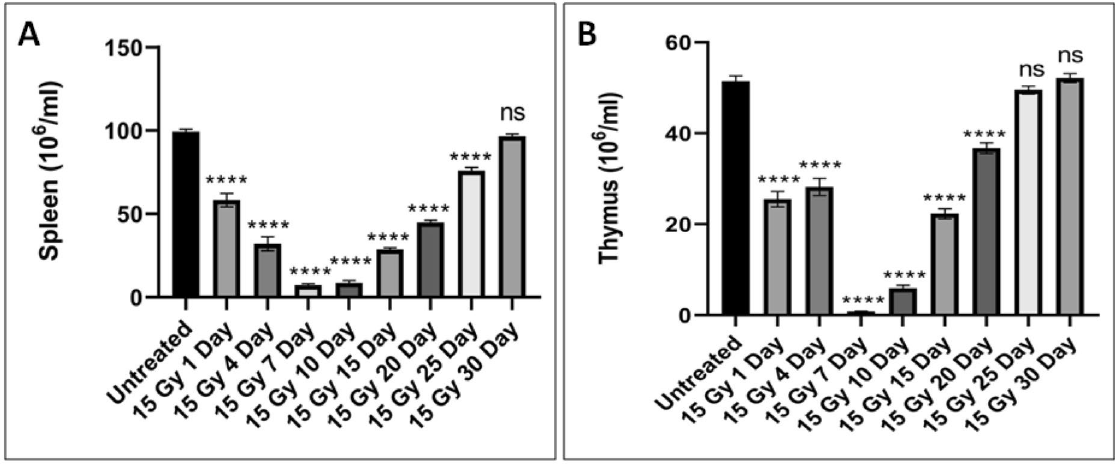
Figure 5. Effect of 15 Gy localized dose on the splenocyte and thymocyte counts in mice post-irradiation. ( A ) Splenocytes counts of untreated and treated mice at various time interval. ( B ) Thymocytes counts of untreated and treated mice at various time intervals. The bars represent the mean ± SD of 6 animals. A value of p < 0.05 is considered statistically significant *p < 0.05, **p < 0.01, ***p < 0.001, ****p < 0.0001 , ns = not significant (p > 0.05).